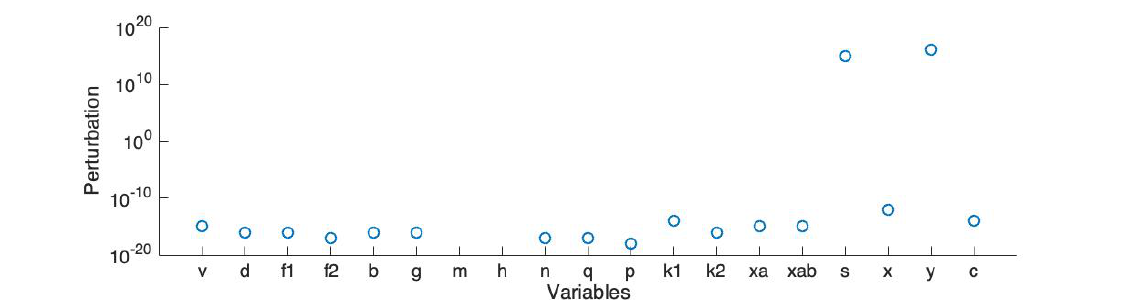
Figure 6. Stability analysis: smallest absolute values of perturbation on each variable which stabilize the